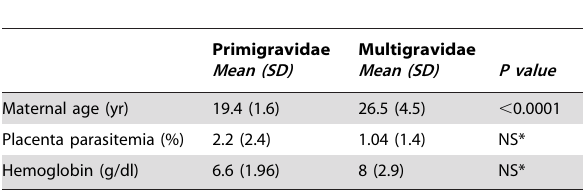
Table 1. Characteristics of the study population in the mass spectrometry based proteomics